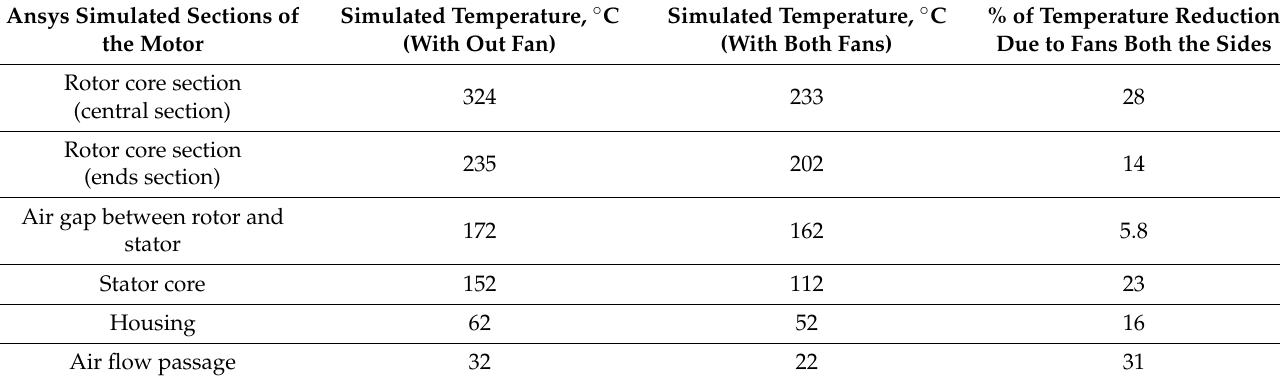
Figure 7. Schematic diagram of an IM with air gap fan [37]. Table 5. Temperature distribution ( a ) without a fan; ( b ) with fan